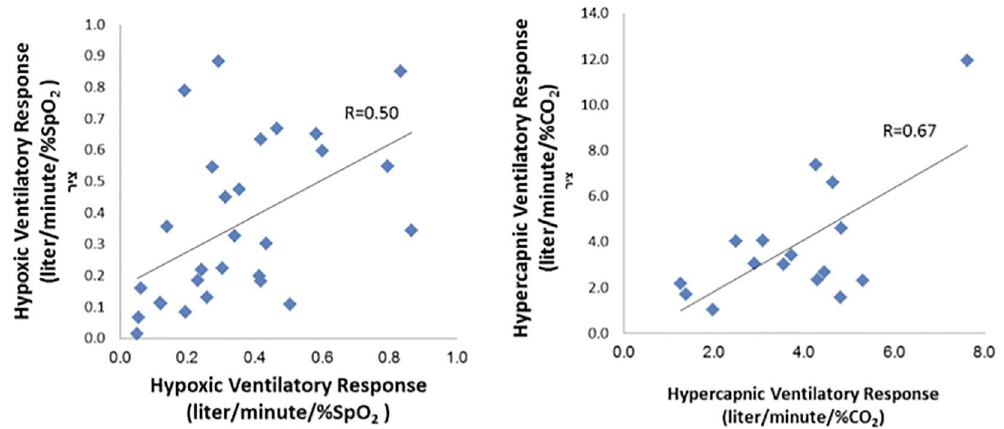
Fig 3. Correlation between test and re-test of hypoxic (N = 28 participants) and hypercapnic (N = 16 participants) responses.